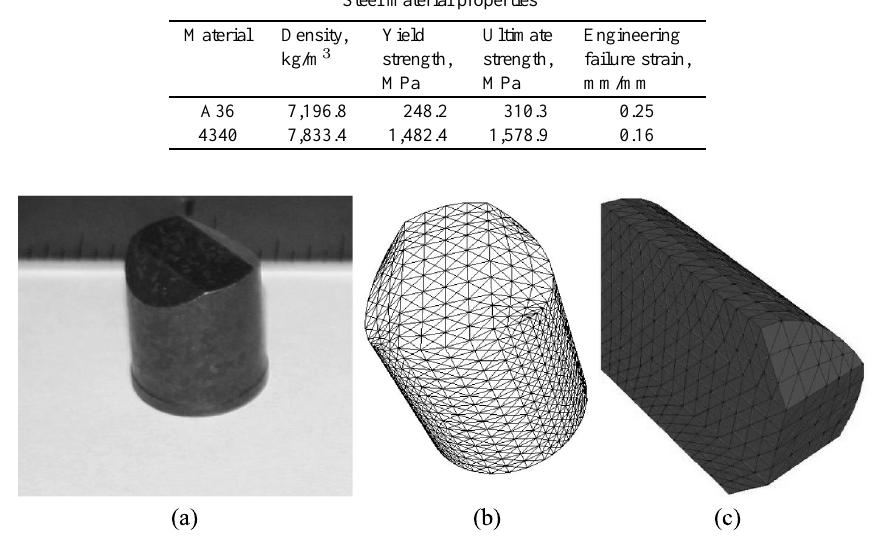
Fig. 2. Views of FSP (a) actual, (b) full, and (c) half